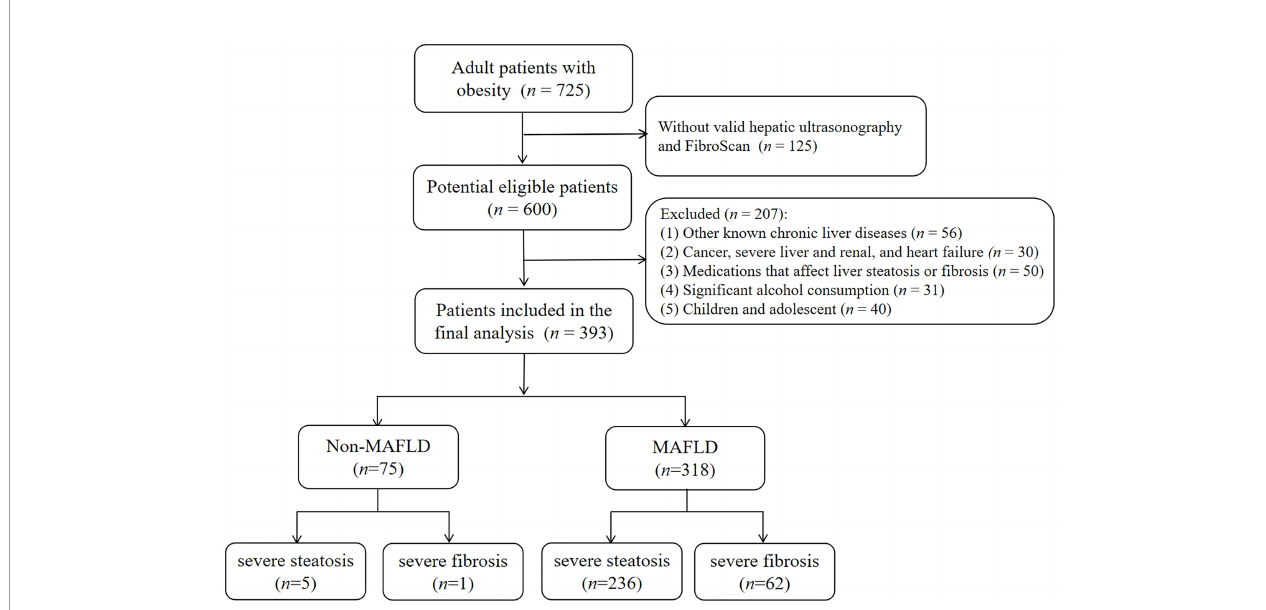
FIGURE 1 | Flowchart of study enrollment. Of 725 adult obese patients, those who did not meet inclusion criteria ( n =207) were excluded. Another 125 patients without valid hepatic ultrasonography and FibroScan were also excluded. As a result, 393 patients were included in the fi nal